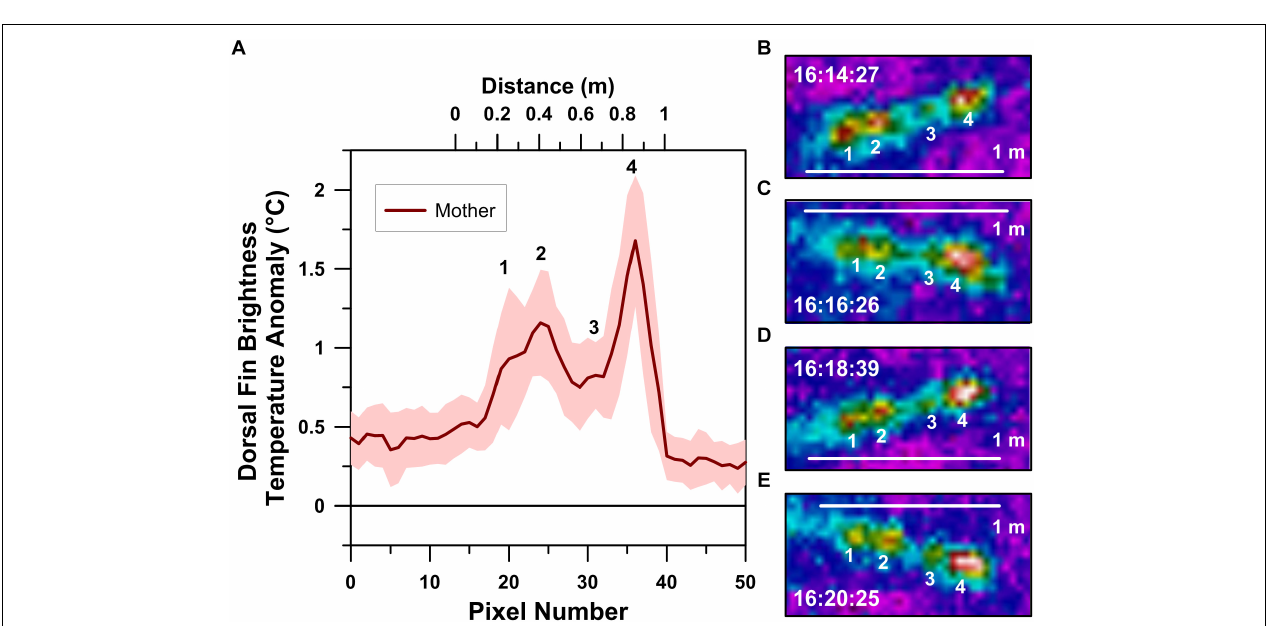
FIGURE 2 | Thermographic blowhole profiles of a logging humpback whale mother-calf pair measured using a drone-deployed radiometric infrared camera (A) . Infrared spectrum images of the mother whale’s lanceolate (i.e., tapered oval) blowholes and blow (B) and the calf’s ovate blowhole/nasal area (C) .